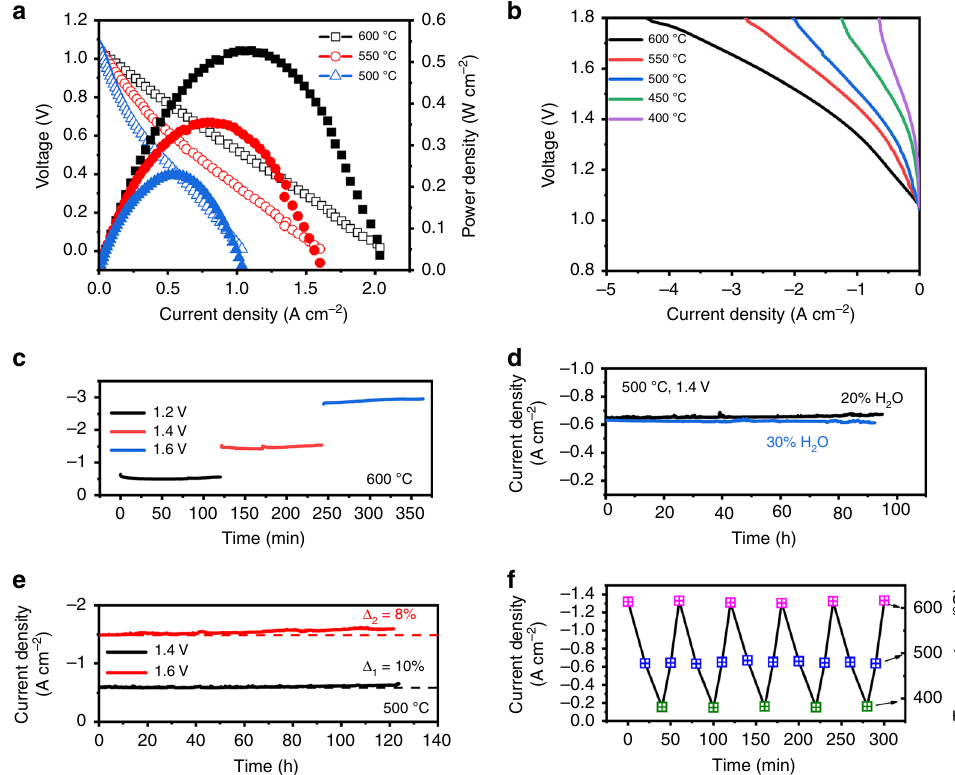
Fig. 3 Electrochemical performances of PCEC with PNC oxygen electrode. a Performance in fuel cell mode (pure H 2 is used as fuel). b Current – voltage curves measured in electrolysis mode at various temperatures and dry 10% H 2 and wet air (~10% H 2 O) are used as reactant gas in hydrogen electrode and oxygen electrode, respectively. c Current density response at different constant voltage of 1.2, 1.4 and 1.6 V at 600 °C. d Durability testing of the cell in different steam concentrations (20 and 30% H 2 O) at 500 °C. e Stability testing of the cell at constant voltage of 1.4 V and 1.6 V at 500 °C. f Thermal cycle durability of the cell between 400 and 600